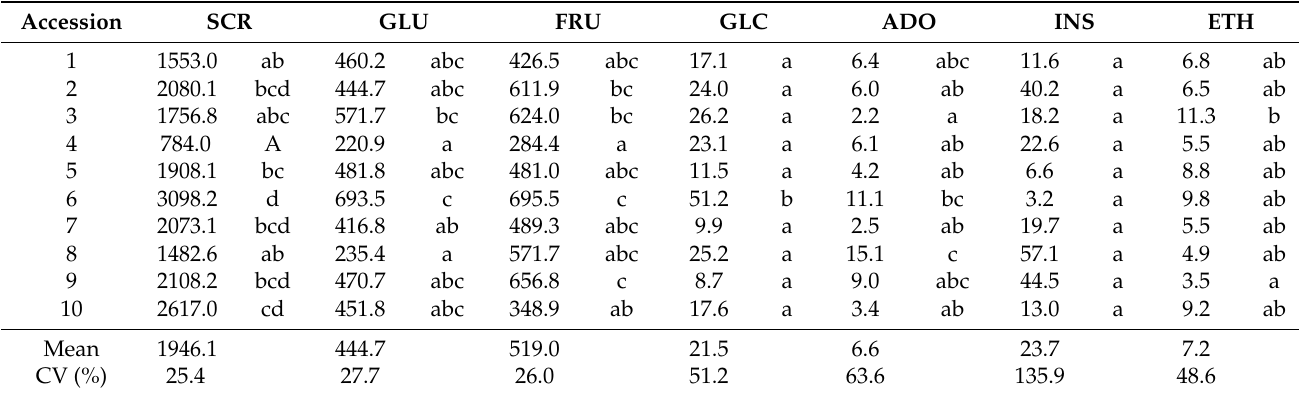
Table 2. Means (fruits quintuplicate for each accession) of the sugars and related compounds determined by NMR and expressed in mg 100 g − 1